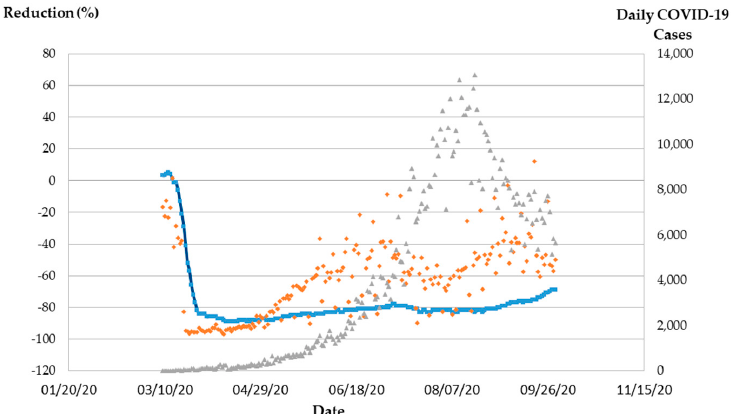
Figure 2. Percentage reduction (%) in traffic congestion (red) and urban transport use (blue), com- pared to the number of daily COVID-19 infections (gray). Bogota city, Colombia.